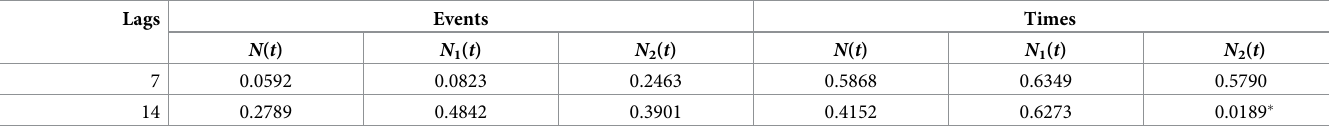
Table 5. P-values of Ljung-Box test applied to events and inter-arrival times of N ( t ), N 1 ( t ) and N 2 ( t ). Significant differences ( α = 0.05) are identified with an asterisk ( � ). Lags Events